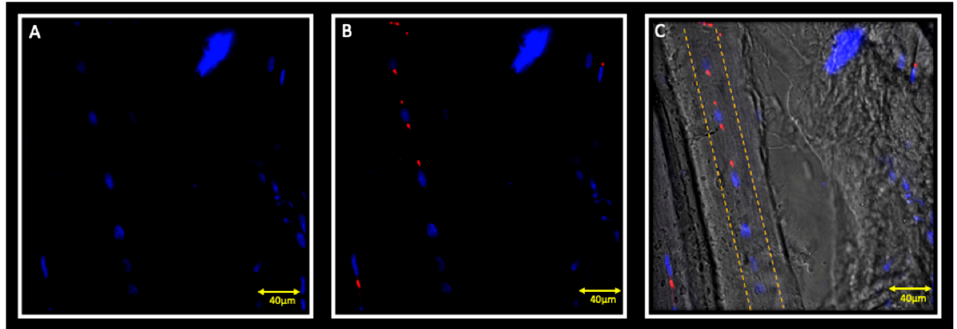
Figure 3. Immunofluorescence reaction in double localization performed on the contralateral masseter muscle. Pictures show muscle fibre characterized by cells that are positive for MyoD ( B ) but negative for Myf5 ( A ); these cells start fusing to form young myotubes, characterised by centrally located nuclei ( C , dashed line). Nuclei are stained with DAPI (blue channel).